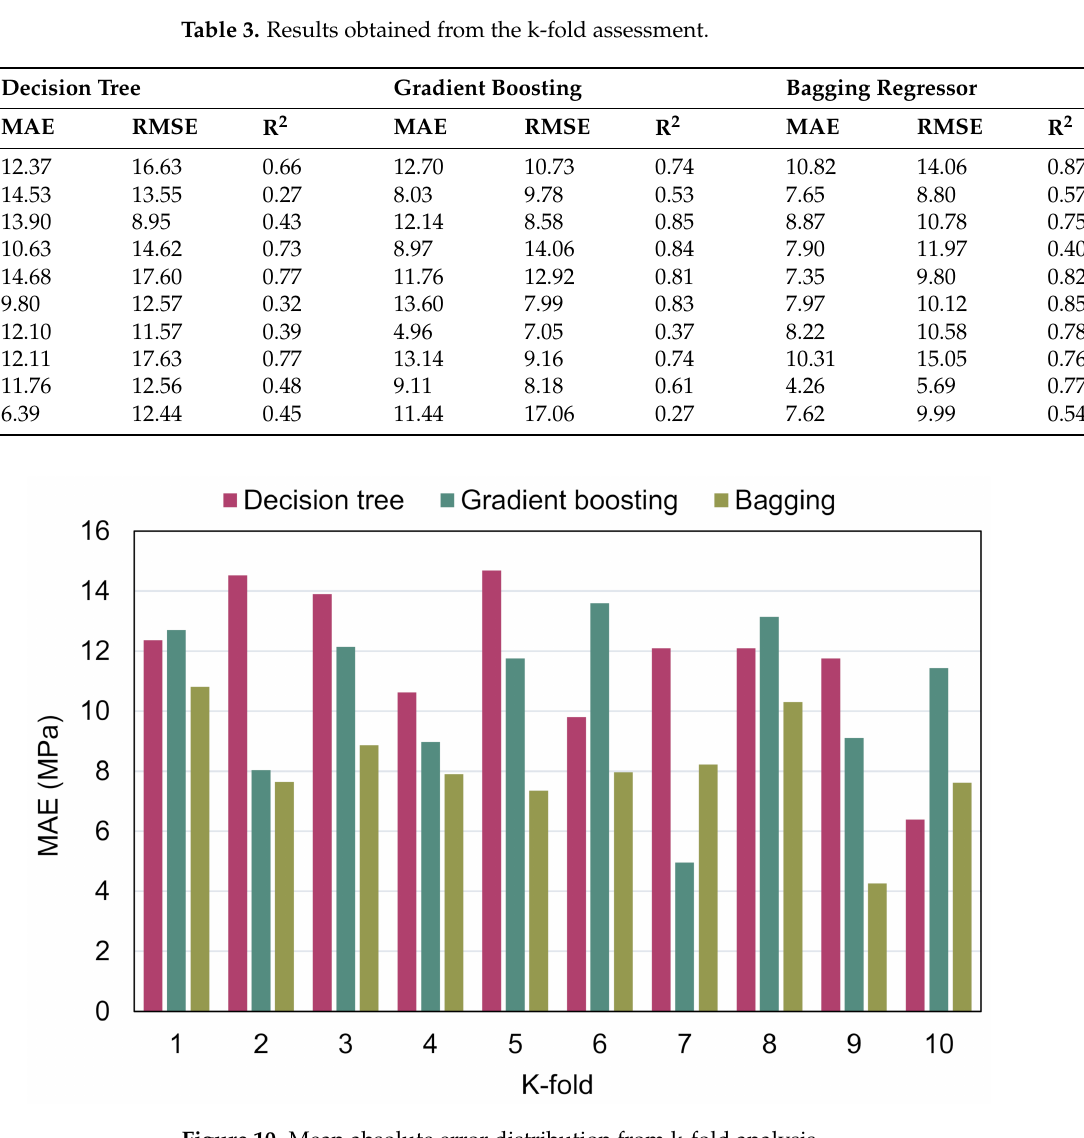
Figure 10. Mean absolute error distribution from k-fold